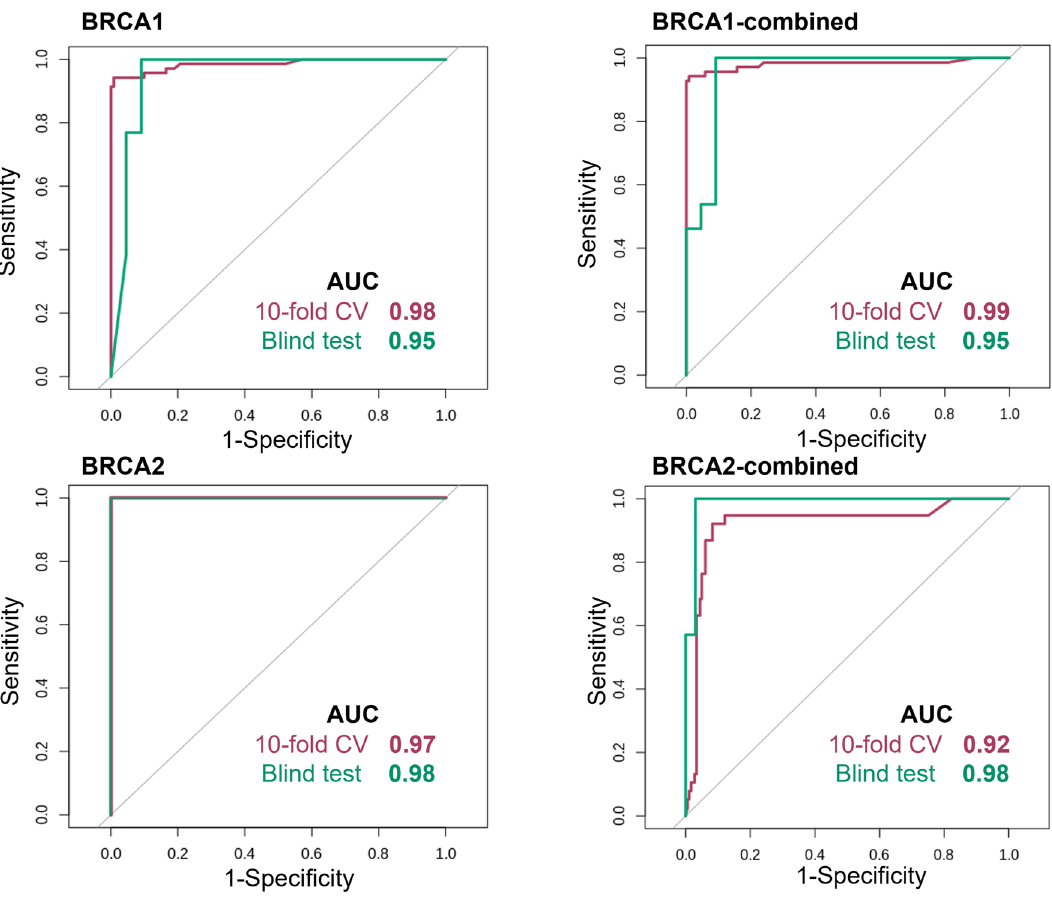
Figure 3. Receiver Operating Characteristic (ROC) curves for BRCA1 (top) and BRCA2 (bottom). Our predictive models accurately identified pathogenic variants with AUC > 0.92 on cross-validation and blind